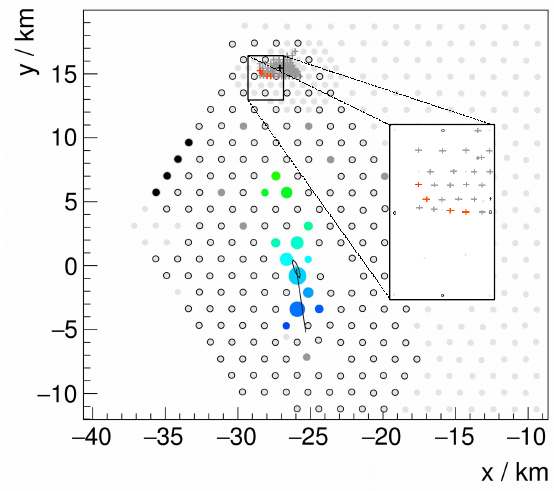
Fig.11. Simulatedfootprintsoftheradioemissionofextensiveairshowerswithvariouszenithanglesinthe30–80MHzfrequencybandforanairshower withanenergyof5 ⇥ 10 18 eV.ThedetectionthresholdgovernedbyGalacticnoisetypicallycorrespondsto ⇡ 1–2 µ V / m / MHz.Thefootprintissmallforair Figure 4. Simulated footprints of the radio emission of extensive Figure 6 : View of the southern-most event visible in Fig. 4. The blue to green circles indicate the Figure 3. A measured horizontal air shower. The blue to green showerswithzenithanglesupto ⇡ 60  ,butbecomesverylargeforinclinedshowerswithzenithanglesof70  orhigher.Thewhiterectangledenotesthe measurement with the surface dector, size indicating energy deposit and color encoding arrival time. air showers with various zenith angles in the 30 − 80 MHz fre- size of the 50  inset. The strong increase of the area illuminated by inclined air showers is due to the large geometrical distance of their emission region circles indicate the measurement with the Surface Dector, their Dark-grey circles indicate isolated particle detections rejected in the reconstruction. The radio signal fromtheground. quency band for air showers with an energy of 5 · 10 18 eV. The in- sizes indicating energy deposit and the color encoding arrival Source: Adaptedfrom[30]. extends over a significantly larger area than the particle distribution. sets show results for di ff erent zenith angles, drawn to scale with times. Dark-grey circles indicate isolated particle detections re- the main figure. The detection threshold governed by Galactic jected in the reconstruction. The radio signal extends over a sig- simulations. There is thus still room for improvement when employing a detailed reconstruction of noise typically corresponds to 1 − 2 mV / m / MHz nificantly larger area than the particle distribution [31]. the radio signals of inclined air showers, which is currently under investigation.